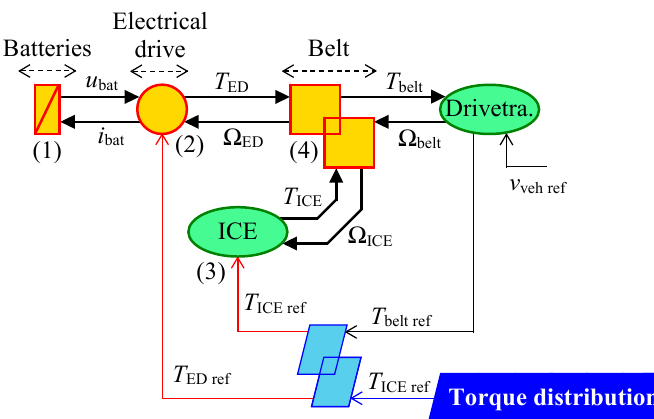
Figure 3. Reduced EMR for torque distribution strategy development.